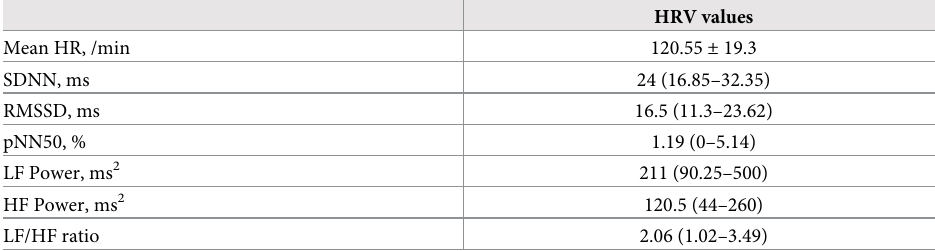
Table 2. HRV parameters of all